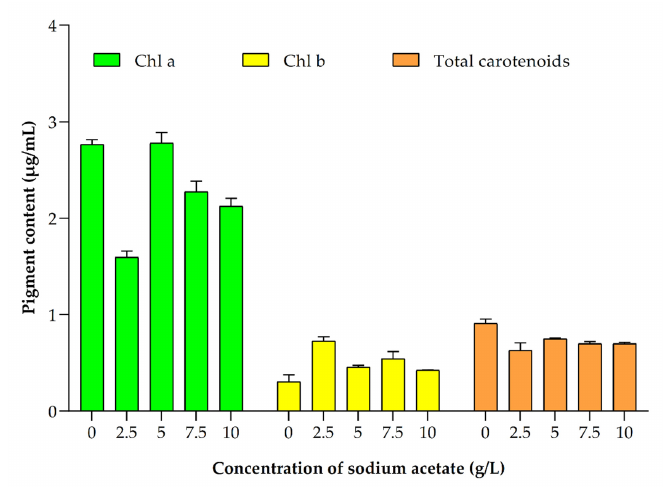
Figure 7. Impact of different concentrations of sodium acetate on Picochlorum sp. BDUG 100241 biomass to the production of chla, chlb and total carotenoids under mixotrophic conditions.